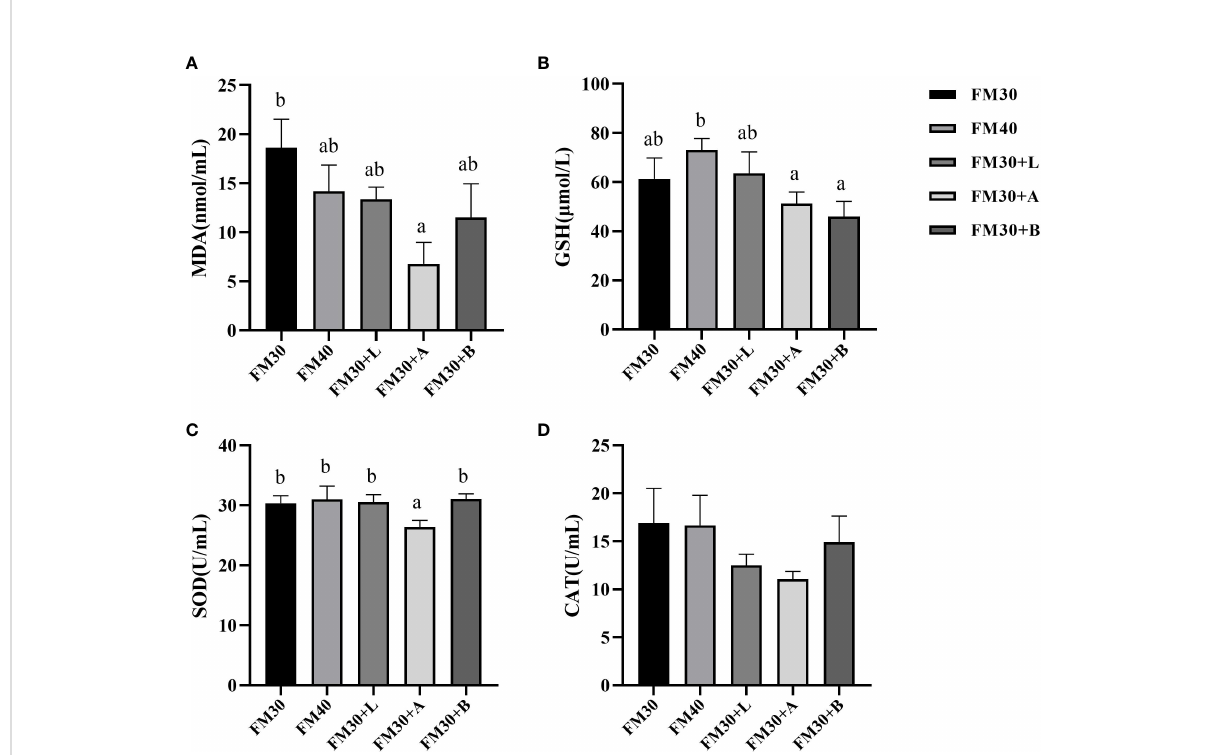
FIGURE 3 Effects of limonene, allicin and betaine on serum antioxidant capability of M. salmoides for 9 weeks. (A) Malondialdehyde (MDA); (B) glutathione (GSH); (C) superoxide dismutase (SOD); (D) catalase (CAT). Values (mean ± standard error of the mean, SEM) in bars that have the same letter are not signi fi cantly different (P > 0.05) between